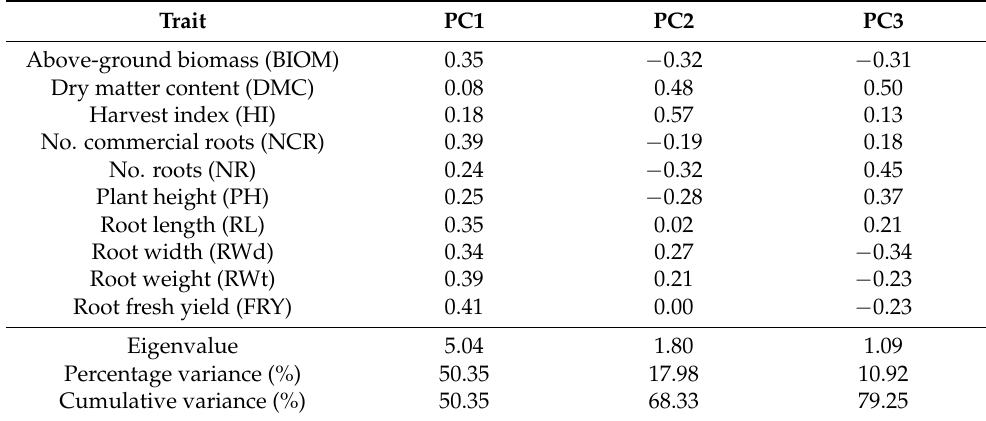
Table 5. Eigenvalues, variances, and loading scores of 11 quantitative traits assessed in six environ- ments in South